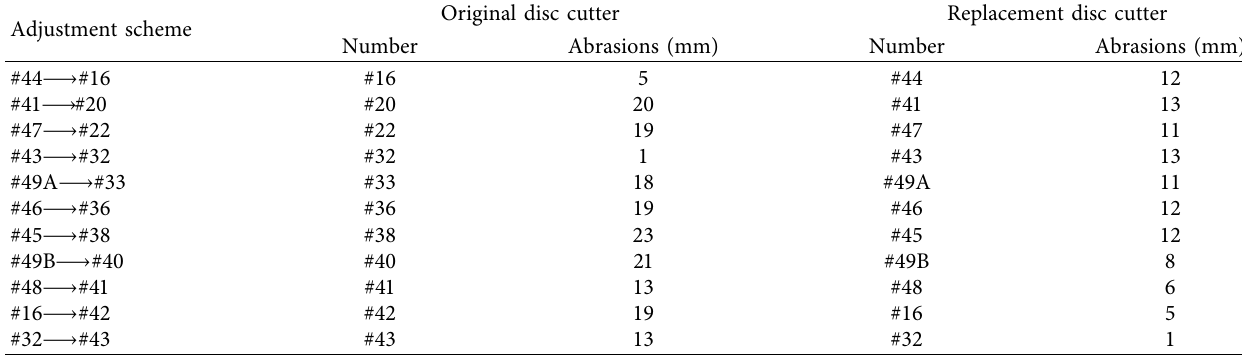
Figure 11: Rock-breaking effect of model 4: (a) before loading; (b) after loading. Table 4: Disc cutter height difference adjustment